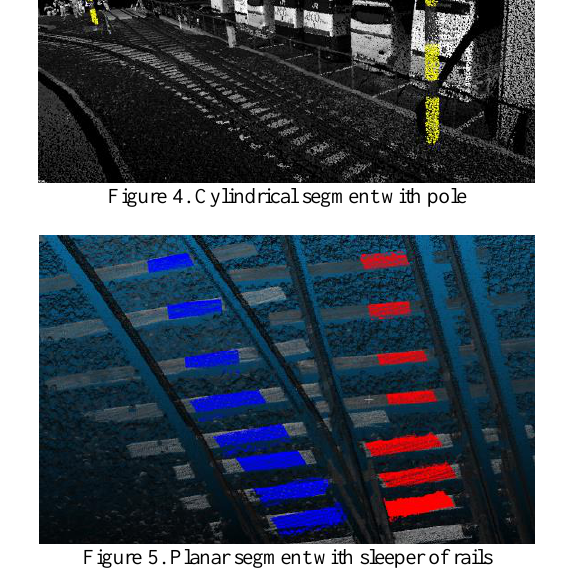
Figure 5. Planar segment with sleeper of rails